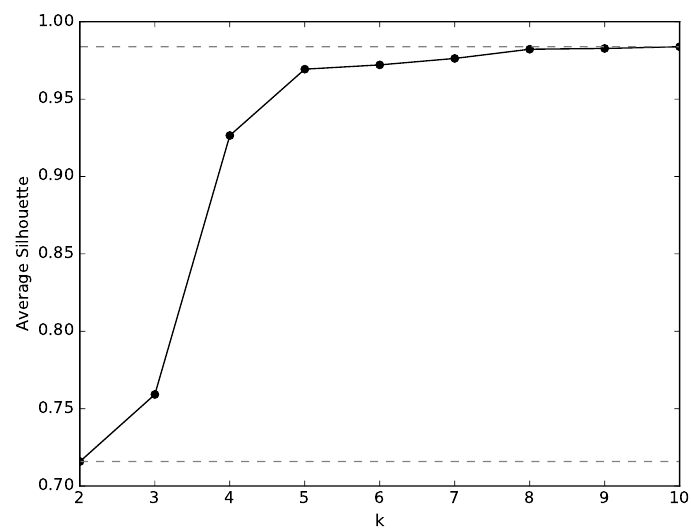
Figure 6. Average silhouette values for k between 2 and 10, applied to the results of Environment